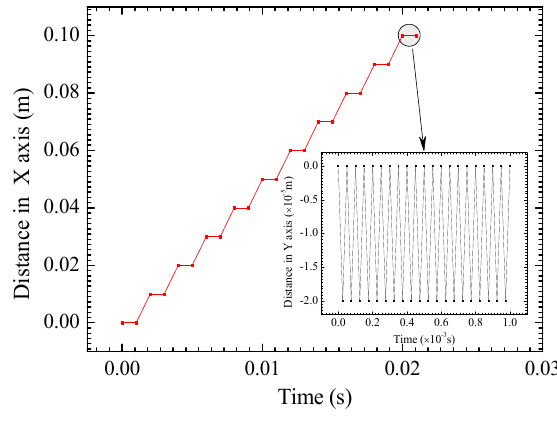
Figure 7. Movement law of pin.